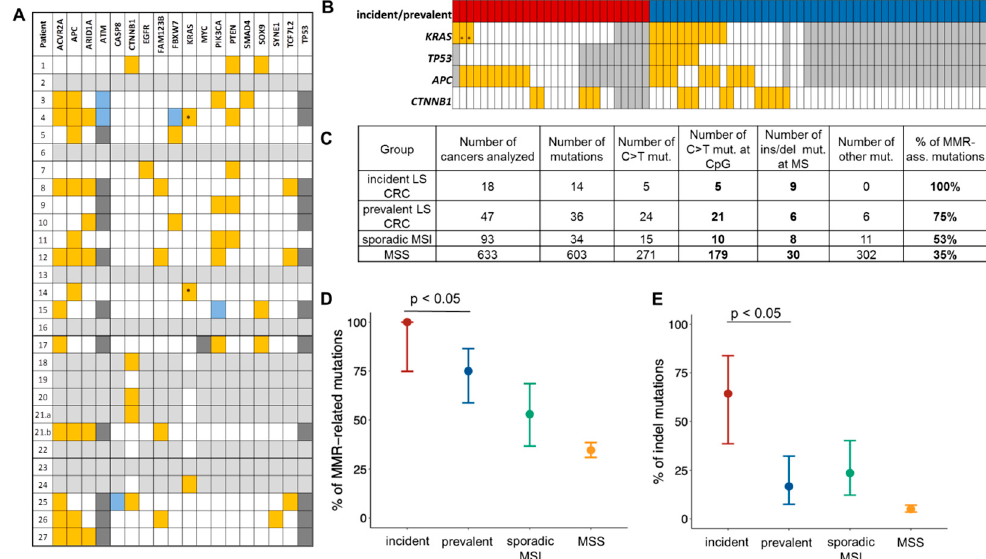
Figure 3. Mutational profile and MMR deficiency signatures in incident LS CRC. ( A ) Mutational characteristics of incident cancers (panel restricted to genes found mutant in at least one sample). Color code: orange—mutant, white—wild type, grey—n.a.; dark grey—known polymorphism, blue—variant of unknown significance; *— KRAS mutations at codons other than codon 12/13. ( B ) Mutation status of CRC genes in incident cancers analyzed in this study and prevalent cancers reported before [32,38] (for cohorts: red—incident CRC, blue—prevalent CRC, for genes—the same color code as in ( A )). ( C ) Summary of the number of specific MMR deficiency ‐ related mutations in incident LS CRC compared to prevalent LS CRC, sporadic MSI CRC and MSS CRC previously reported in Ahadova et al. [38] . ( D ) Comparison of the proportion of all MMR deficiency ‐ related mutations between different CRC groups reveals a higher proportion in incident compared to prevalent tumors (100%, 95% CI: 74.85–100 vs. 75%, 95% CI: 58.7–86.4%; Fisher’s exact test, p = 0.0470). ( E ) Comparison of the proportion of indel mutations between different CRC groups reveals a higher proportion in incident compared to prevalent tumors (64.3%, 95% CI: 38.6–83.8 vs. 16.7%, 95% CI: 7.5–32.3%; Fisher’s exact test, p = 0.0068).